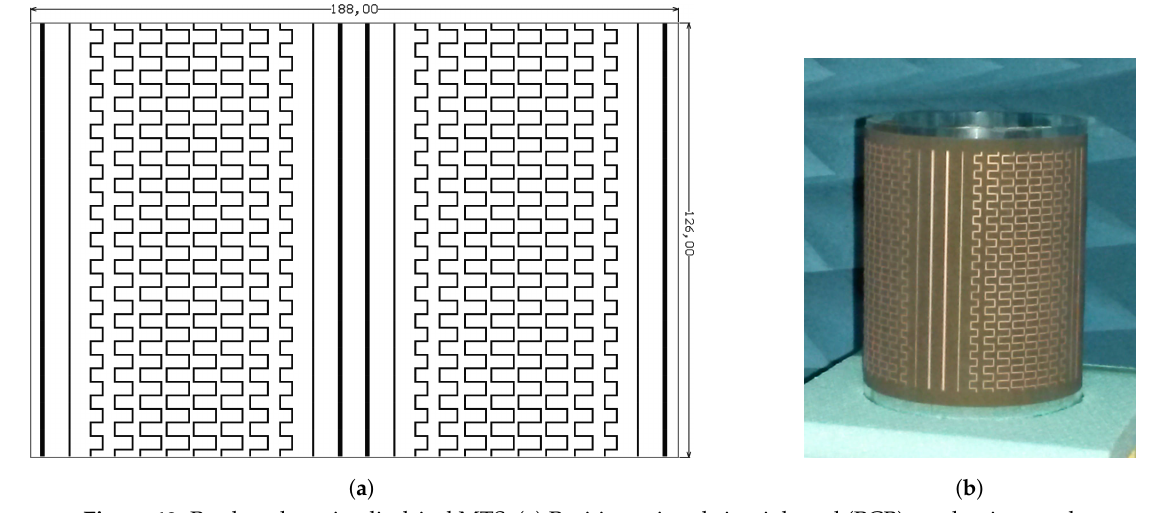
Figure 13. Produced semi-cylindrical MTS. ( a ) Positive printed circuit board (PCB) production mask. Dimensions are in mm; ( b ) the MTS in the measurement environment.